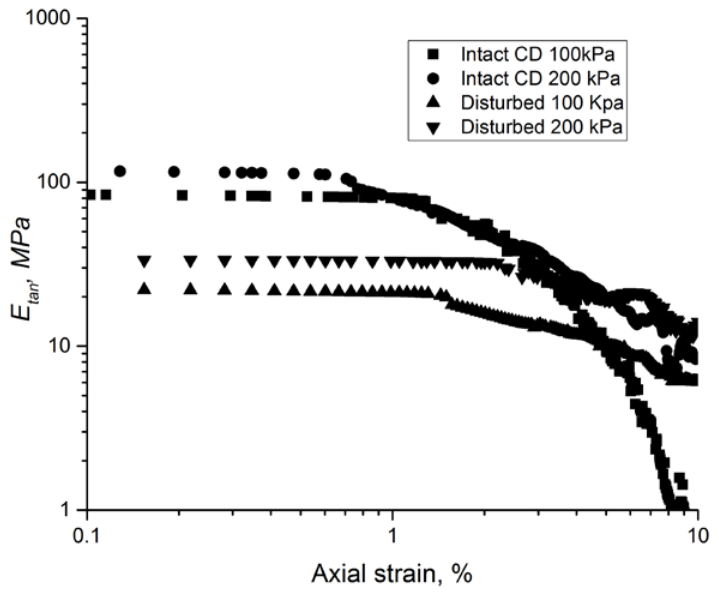
Figure 6. The drained tangential stiffness of both the disturbed and intact soils.